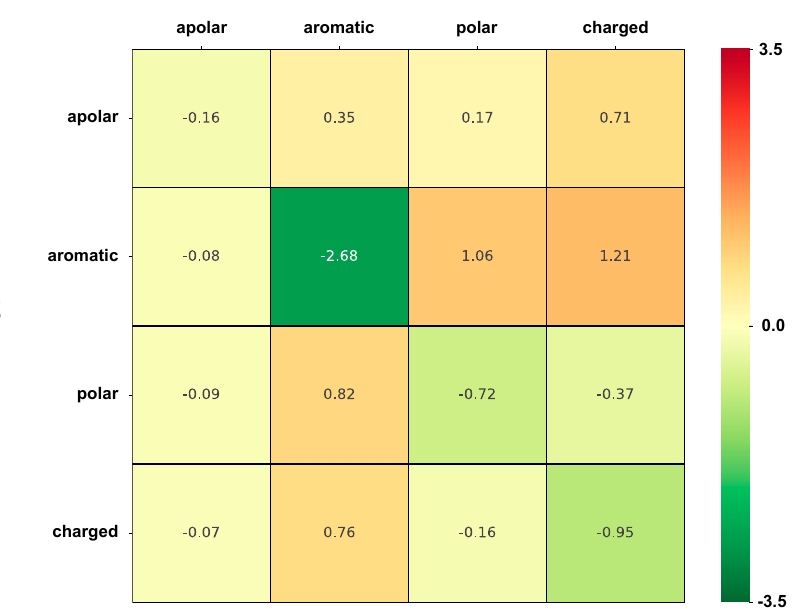
Figure 2. Heatmap shows the strength of association to disease (Log-odd) of variation types grouped according to chemico-physical properties of lateral side chains. Residues are grouped as following: apolar (GAVPLIM), aromatic (FWY), polar (STCNQH), charged (DEKR). The color code spans from green (variant types most frequent in the neutral set) to red (variant type most frequent in the disease related type). Estimated average standard error on reported values is 0.13.